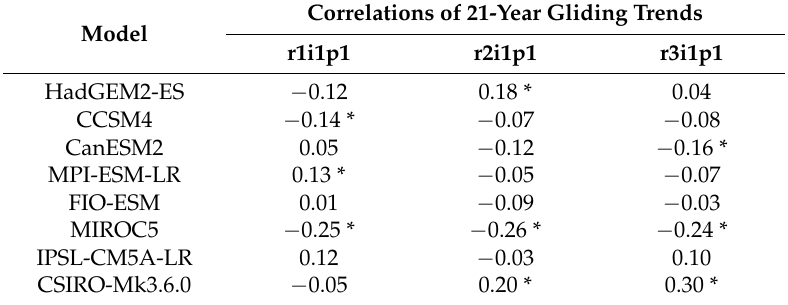
Table 5. Correlations of 21-year gliding trends between spatial mean of surface air temperature and the BANOS index are shown for the period 1850–2100. The value of two-sided 95% significance level is 0.12 for this record length. The significant correlation coefficients are marked